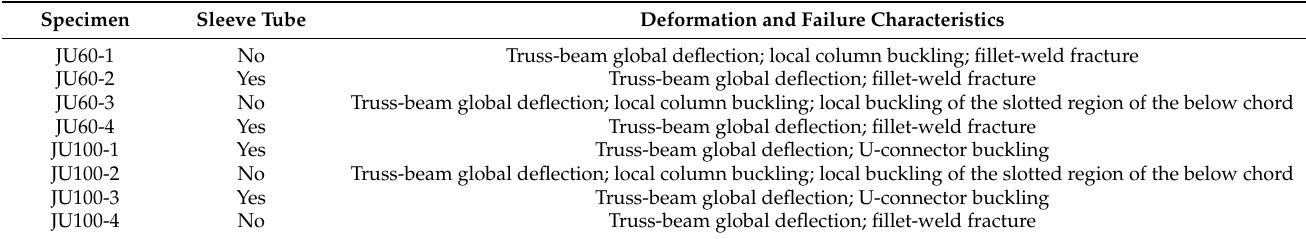
Table 2. Summary of the global and local failure